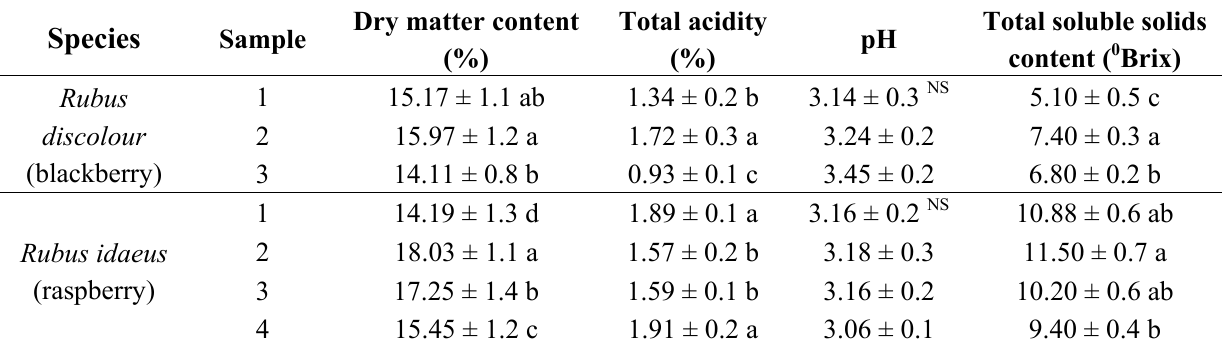
Table 1. The basic nutritional properties in the fruit of wild berries ( R. discolor and R. idaeus